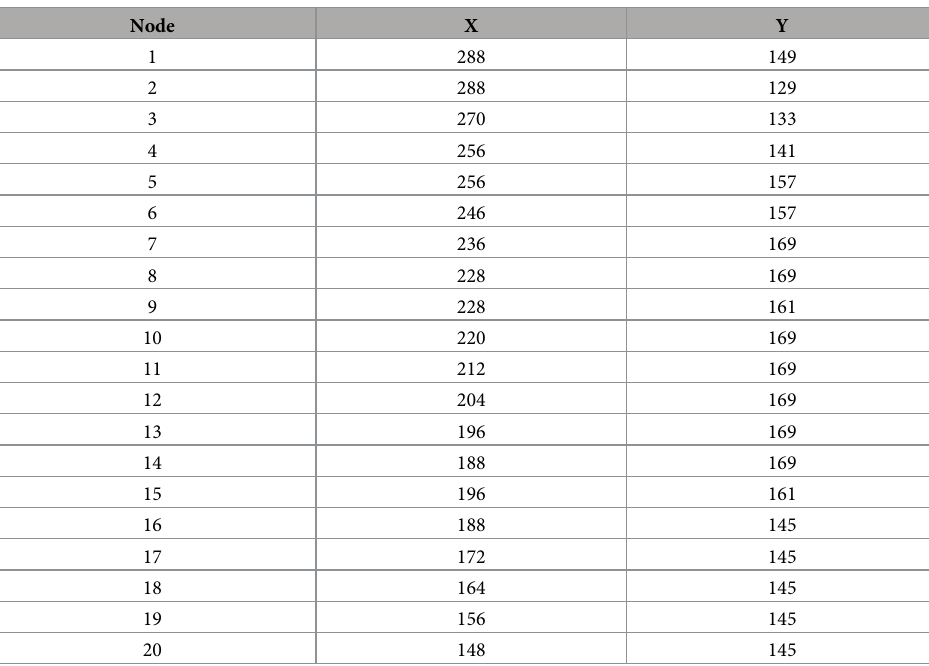
Table 13. Node coordinates with size n =